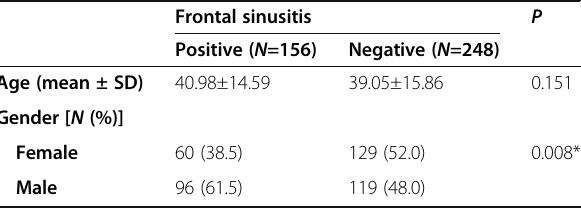
Table 4 Relationship between the frequency of frontal sinusitis and age and